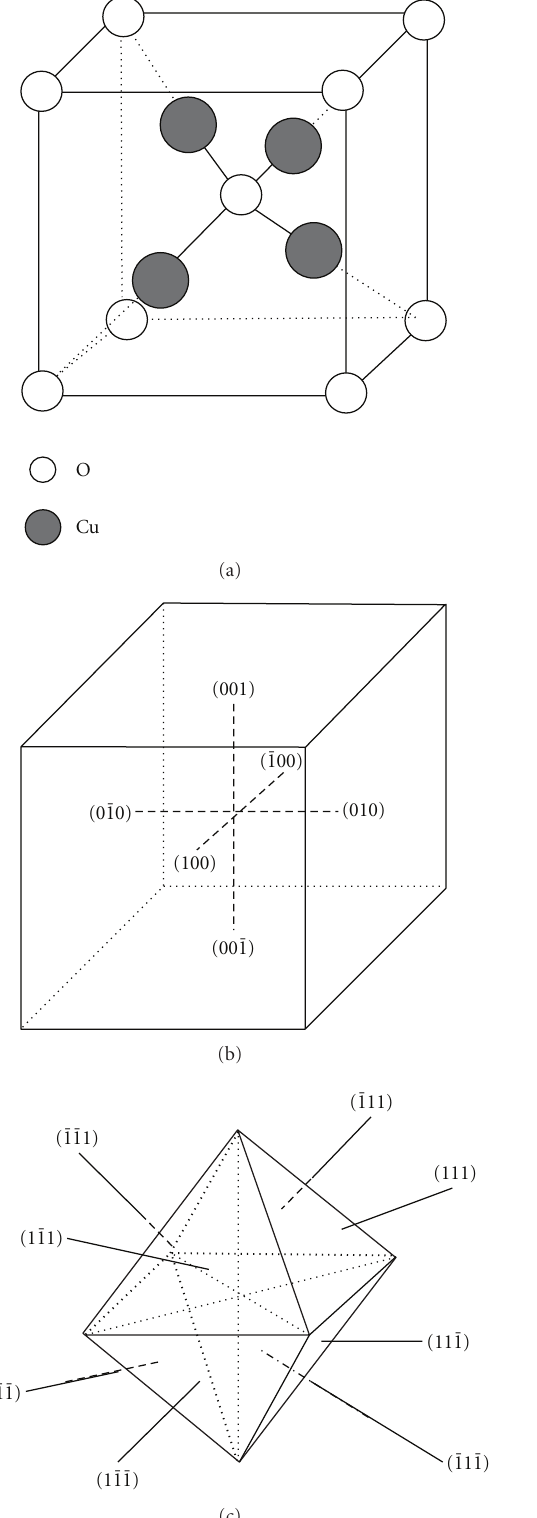
Figure 6: (a) Schematic diagram of the adsorption process on the electrodes; (b) and (c) formation process of Cu 2 O nuclei and octa-